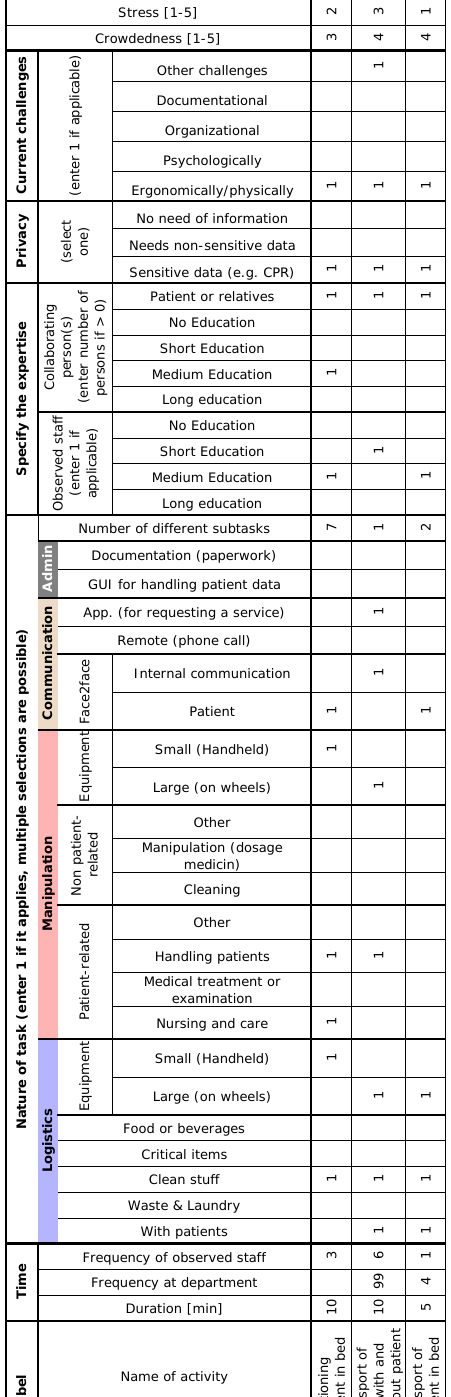
enced patients directly or not. This category is used for ma- nipulation and logistics tasks. However, during data analysis, it turned out that the coding is still too coarse grained to allow for the automatic extraction and grouping of all relevant processes; the dif- ferent steps taken are illustrated in the example use case development in Section 4